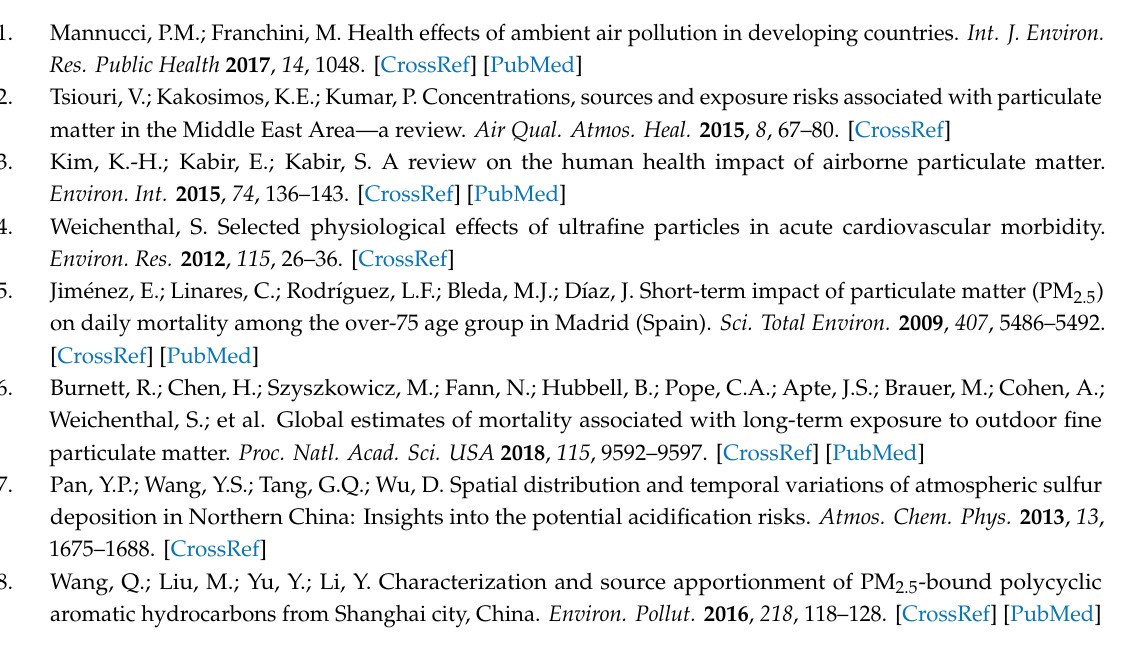
Figure S1: Seasonal wind rose plots for cold and warm seasons. Figure S2: 4-factor PMF resolved profiles and their corresponding contributions to coarse PM. Table S1: Metrological parameters for central Tehran. Table S2: Concentration of species not used in PMF